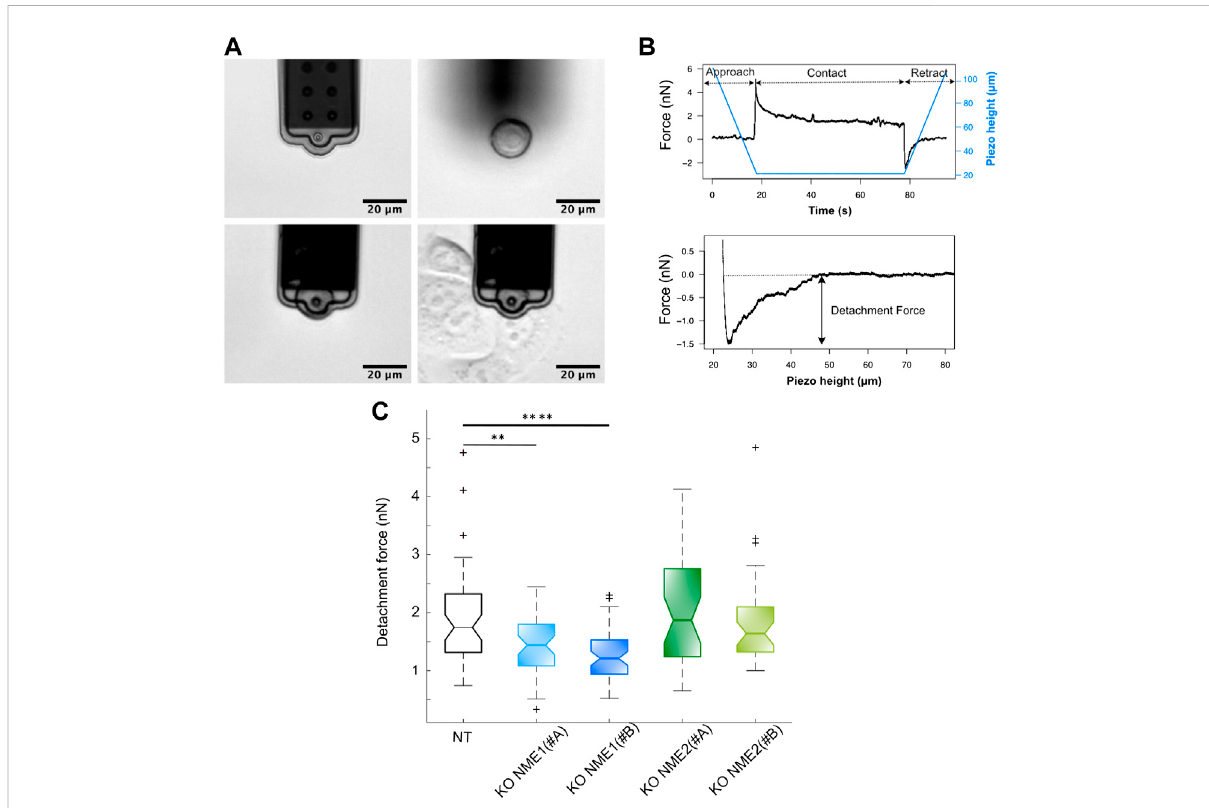
FIGURE 1 Inactivation of NME1 reduces cell – cell adhesion force. (A) Top left: FluidFM ® micropipette. Top right: suspension cell sedimented on the dish. Bottom left: cell picked up by negative pressure in the micropipette channel. Bottom right: cell vs. cell contact. (B) Top: piezo height vs. time (blue) and force vs. time (black) plots of a cell vs. cell interaction. Force increases up to 5 nN for contact, and then height is kept constant for 60 s as cells relax. Finally, cantilever is retracted at a constant speed, and a negative detachment force is observed. Bottom: force vs. piezo height plot example where detachment force is measured. (C) Boxplots of detachment forces from MCF10DCIS.com cells in which NME1 or NME2 was inactivated (on average, n = 45 cells were tested per condition). Notch plots show means ± SEM and fi rst to third quartiles of three